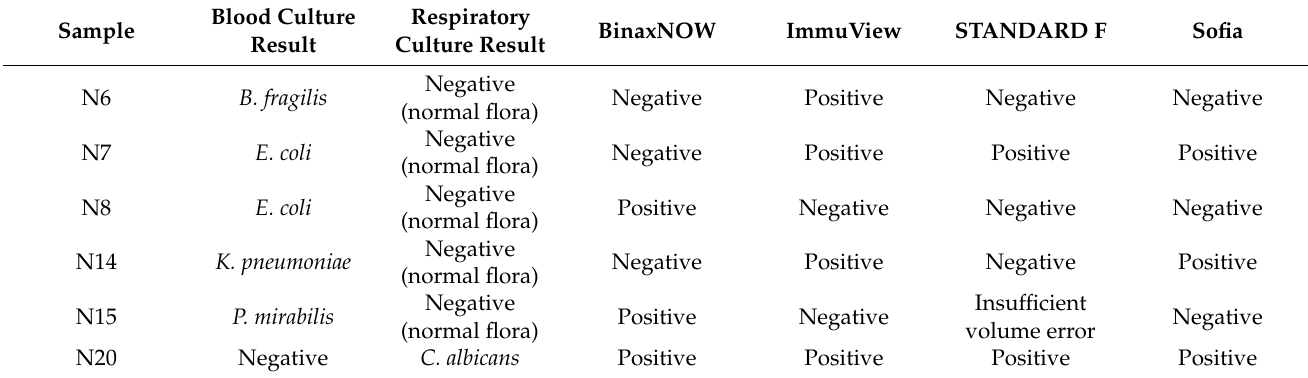
Table 4. False positive and discordant test results in six patients without Legionella infection. Blood Sample